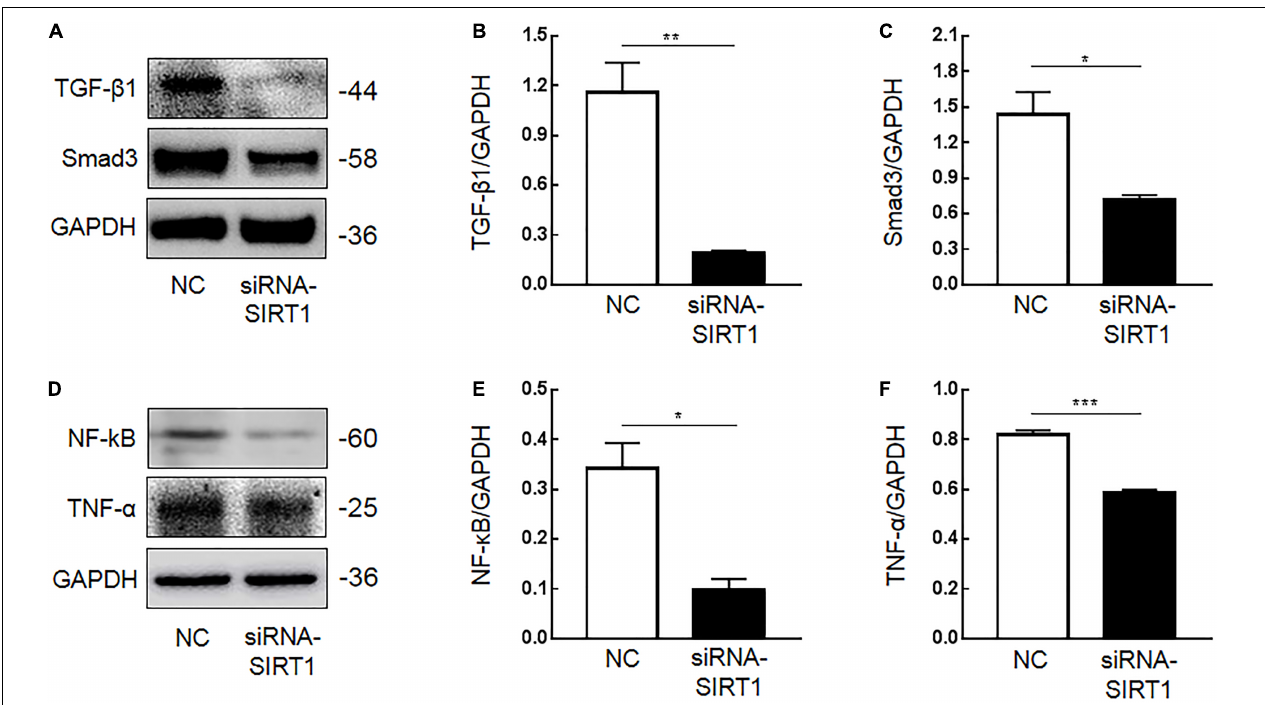
FIGURE 5 | The effect of Sirtuin1 or Silent mating–type information regulation 2 homolog-1 (SIRT1) on the protein expression of fibrosis-related factors in intestinal epithelial cells 6 (IEC6). (A,B) After inhibiting the expression of SIRT1 in IEC6 cells, the expression of transforming growth factor- β 1 (TGF- β 1) protein decreased. (A,C) After inhibiting the expression of SIRT1 in IEC6 cells, the expression of Smad3 protein decreased. (D,E) After inhibiting the expression of SIRT1 in IEC6 cells, the expression of NF- κ B p65 protein decreased. (D,F) After inhibiting the expression of SIRT1 in IEC6 cells, the expression of tumor necrosis factor- α (TNF- α ) protein in the cells decreased. (*Denotes the siRNA-SIRT1 groups compared with the control negative (NC) groups p < 0.05, ** denotes p < 0.01, ***denotes p < 0.001, n =